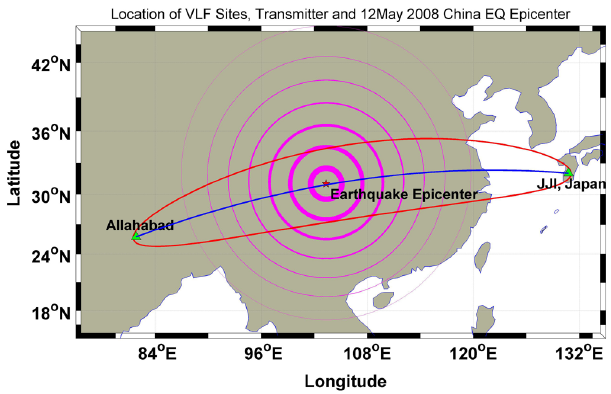
Fig. 1. The great circle path (GCP) between JJI VLF Transmit- ter, Japan, and Allahabad, AWESOME receiving station, India. The conjugative circles show effects of Wenchuan EQ on surrounding region with decreasing EQ intensity as one moves from epicenter. Wave sensitive area defined by 5th Fresnel zone is also